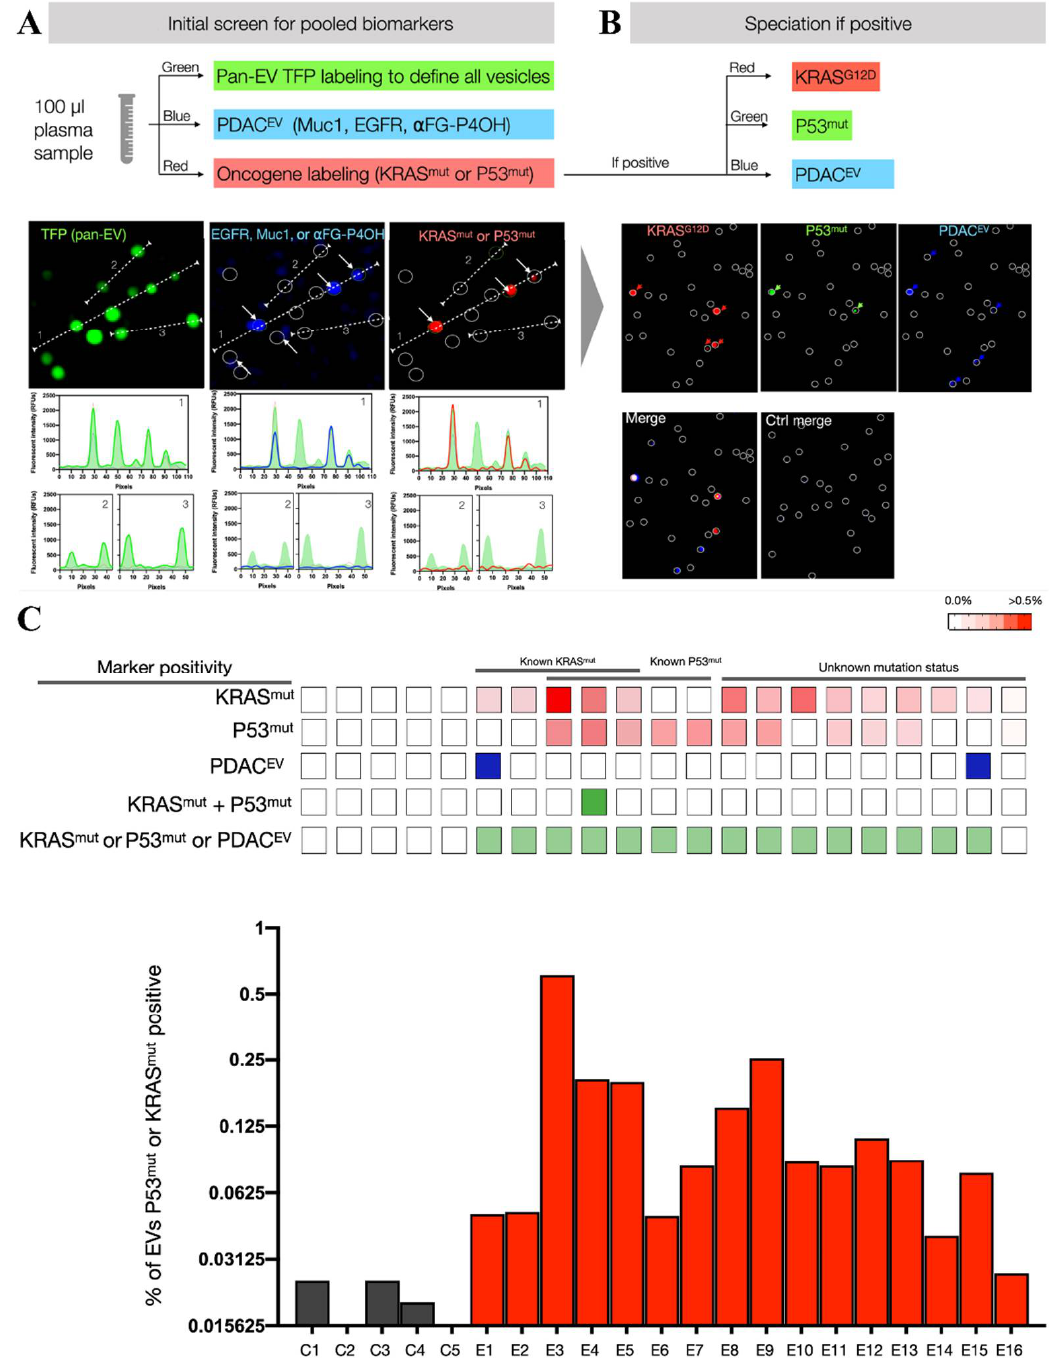
Figure 11. Workflow of the single EV analysis. ( A ) Target EVs are labeled for the pooled biomarkers. ( B ) A separate fluorochrome defined EV in each positive case. ( C ) Analysis of KRAS mut and P53 mut in EVs from clinical samples. Reprinted with permission from [103]. Copyright 2022, American Association for the Advancement of